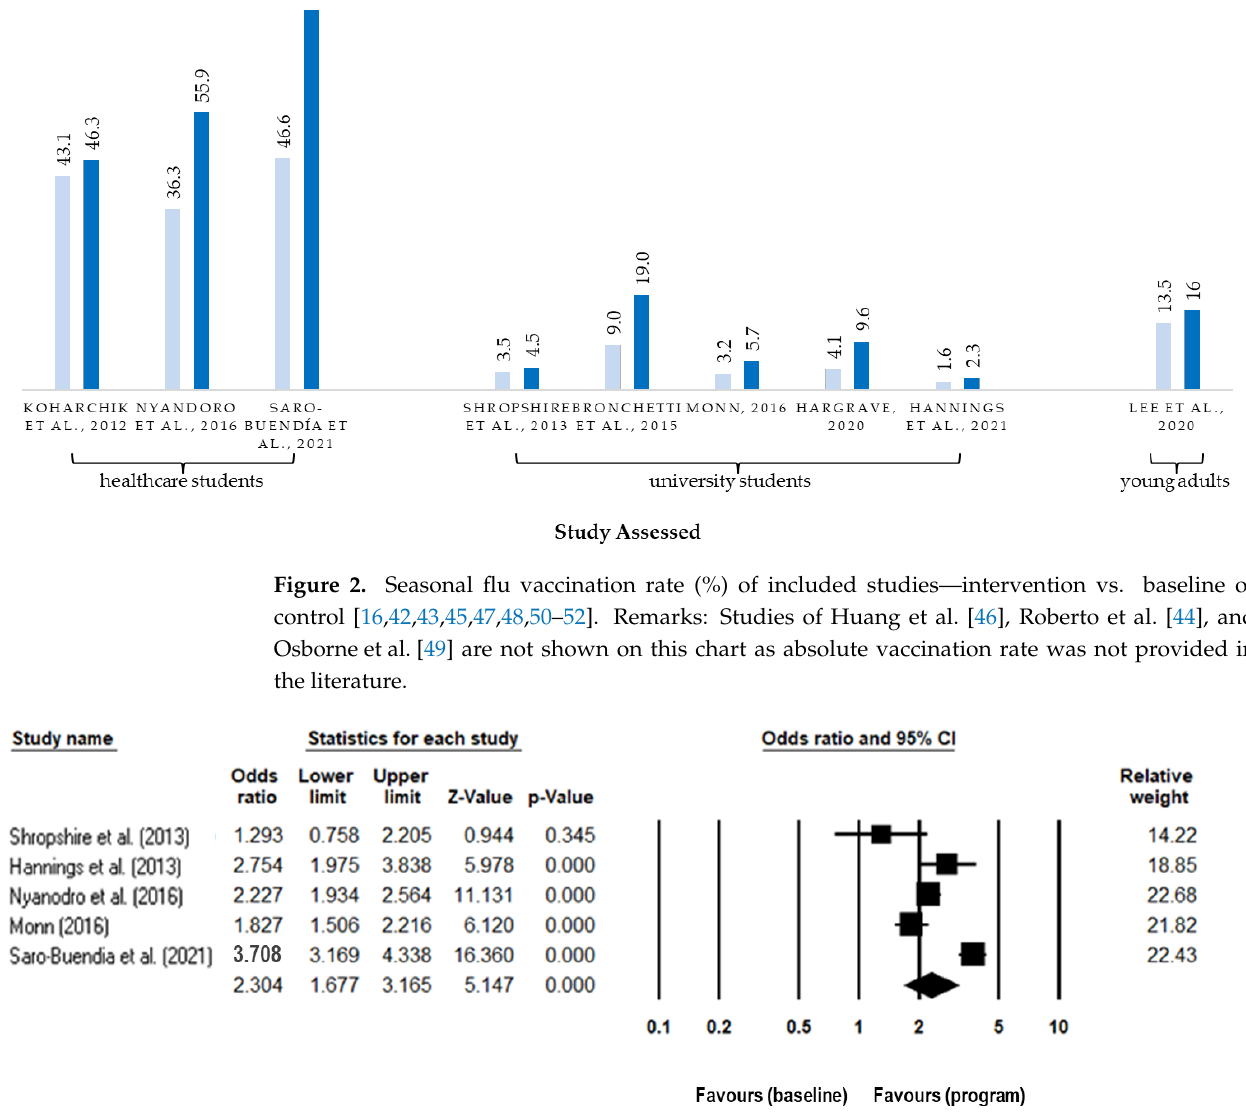
Figure 3. Forest plot of the meta-analysis showing the impact of vaccination interventions [43,48,50 – 52].